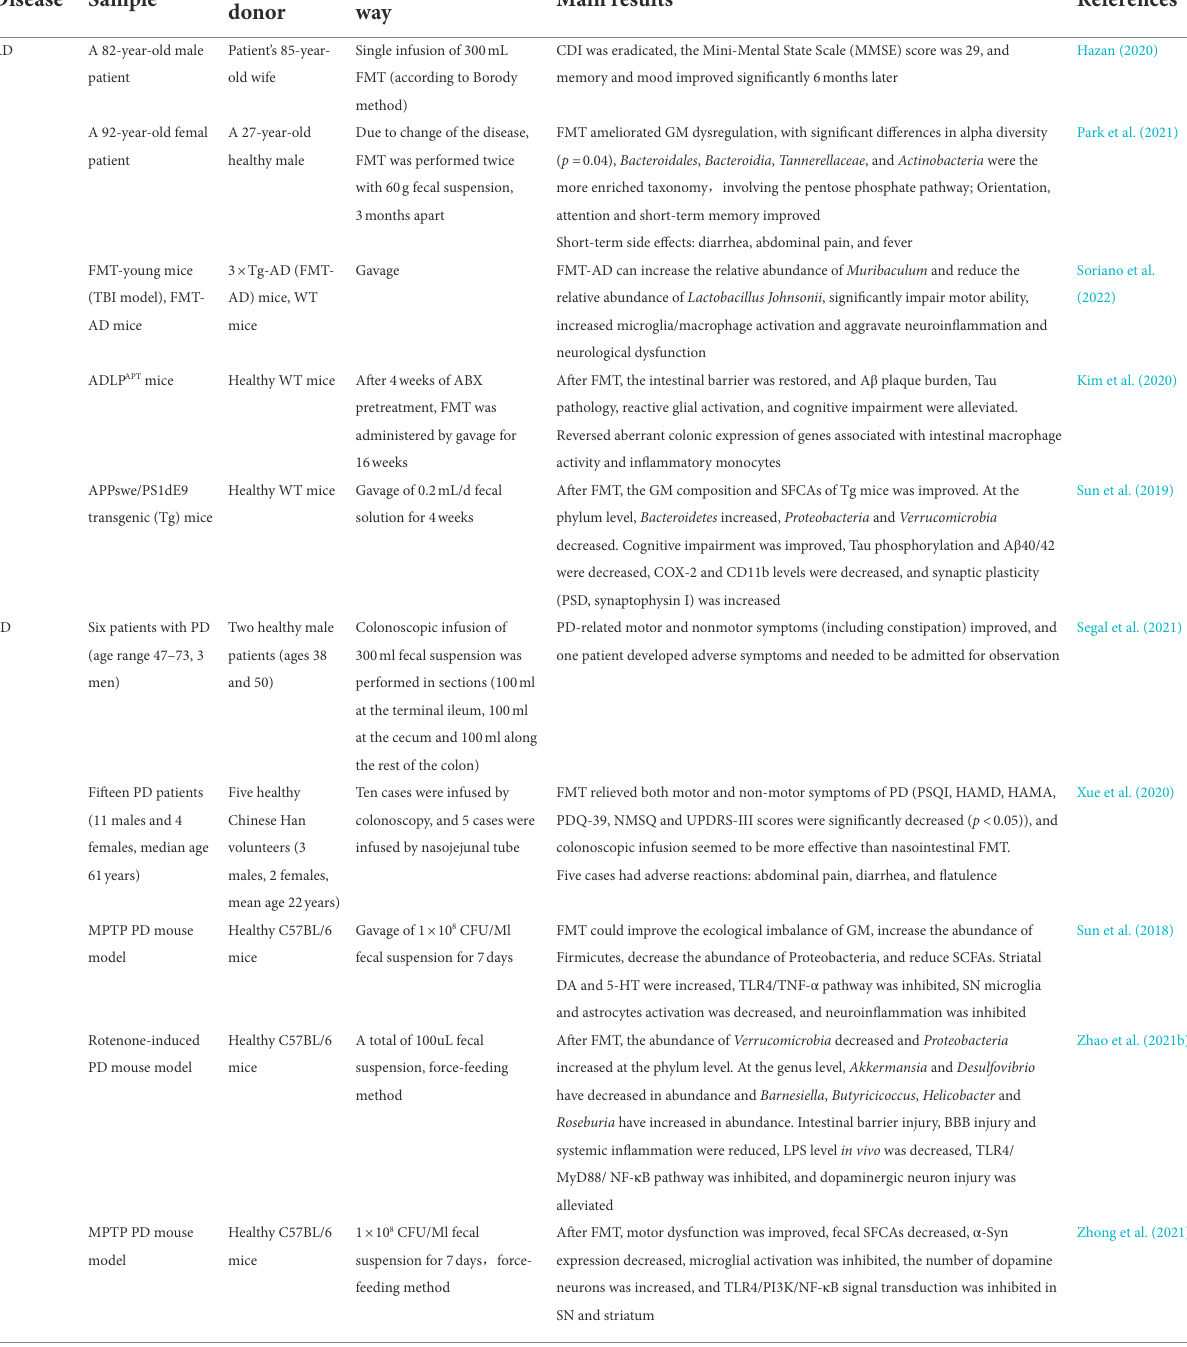
TABLE 1 Application of FMT in AD and PD. Disease